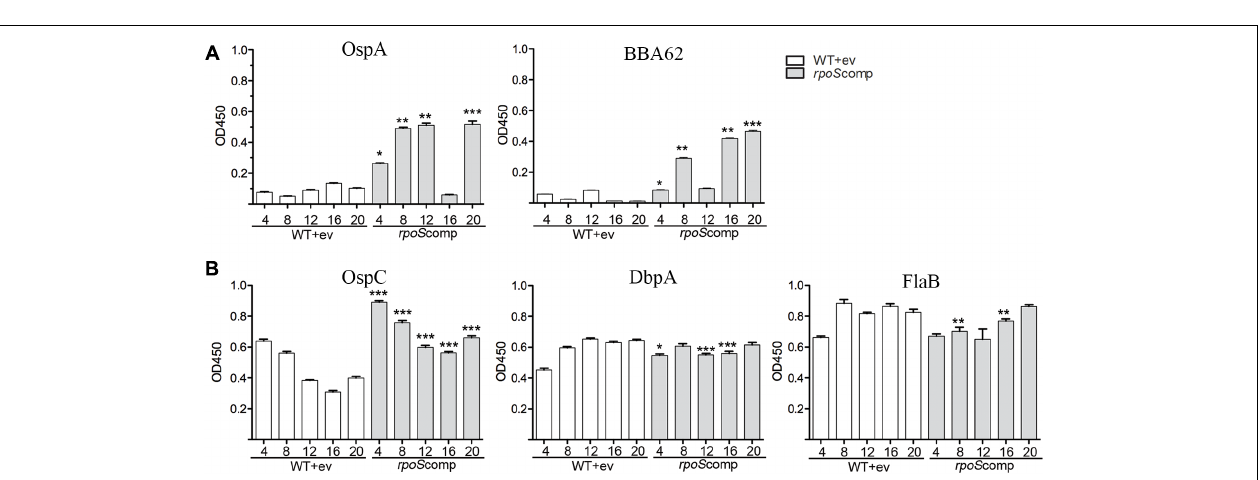
FIGURE 5 | RpoS is required for persistence in mice. Retention of empty vector or rpoS -complementing plasmid by BbP1974 (WT+empty vector) and BbP1754 ( rpoS comp) strains in tissues collected from infected mice 4, 8, 12, 16, and 20 weeks post-infection. Retention was assessed by PCR of individual colonies obtained by semi-solid phase plating of (A) murine ear and skin minimally cultured in BSK-II without antibiotic and (B) larvae fed to repletion on infected C3H/HeJ mice at 4 week intervals beginning 4 weeks post-infection. Columns represent the average of at least 10 colonies per cultured tissue per time point. Numbers on x -axis indicate the number of weeks post-infection. p -Values for pairwise comparisons (WT+empty vector and rpoS comp at the same time point) were determined using a two-tailed t -test; ∗ p ≤ 0.05.